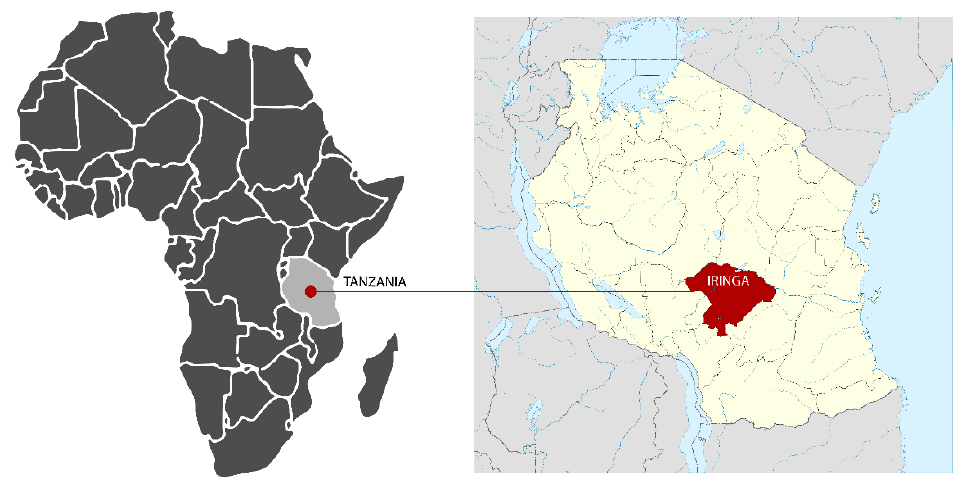
Figure 2. Iringa region, Tanzania.